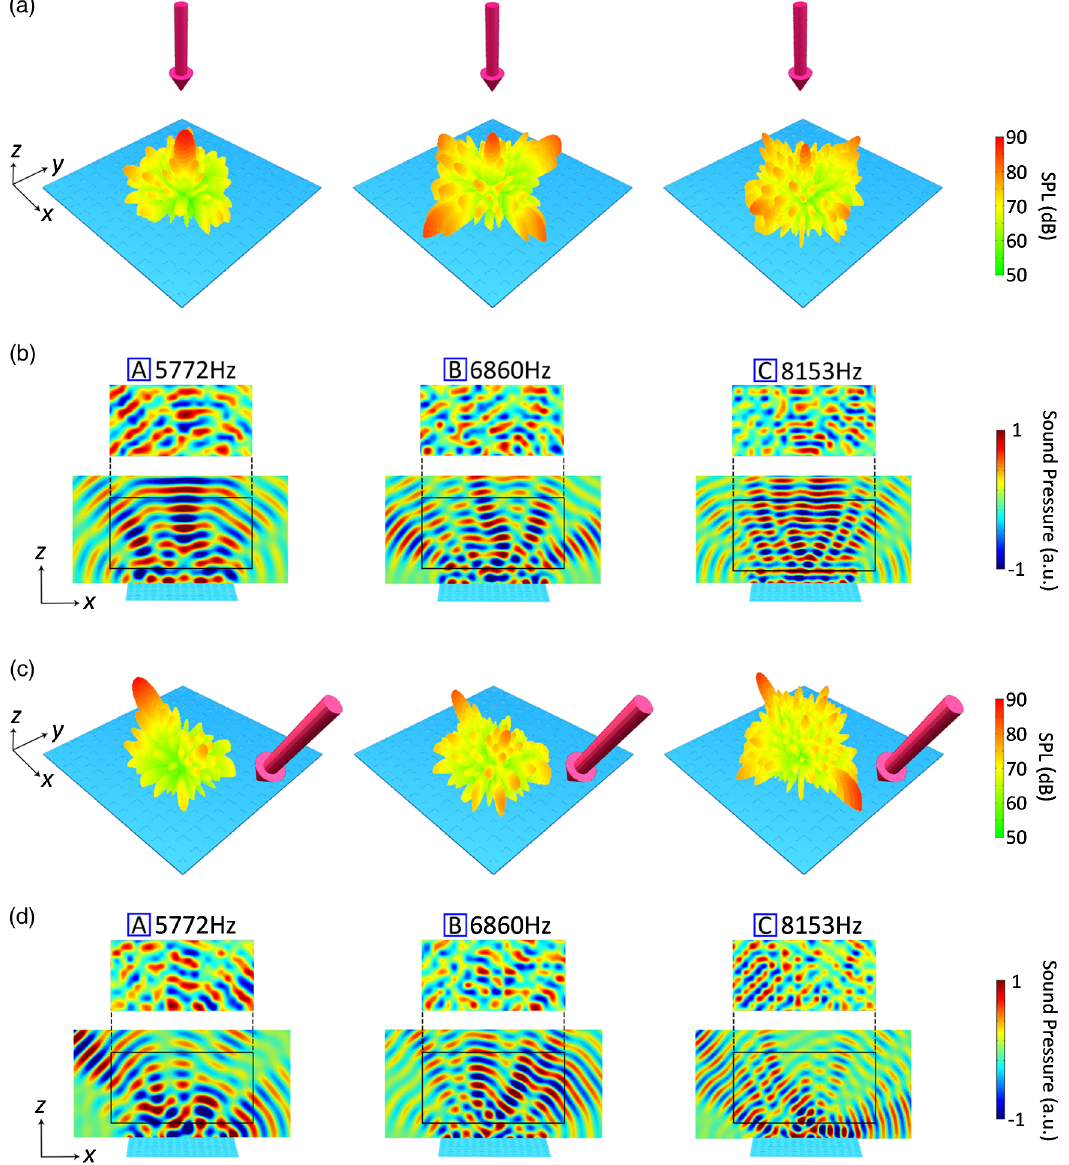
FIG. 6. Simulation and experiment results of the BMSD. (a) The simulated three-dimensional far-field scattering patterns of BMSD1 in the x - z plane at 5772 Hz, 6860 Hz, and 8153 Hz, respectively, with normal incidence. (b) The measured (upper) and simulated (lower) scattered acoustic pressure fields of BMSD1 in the x - z plane. The corresponding results for 45° incidence angles are shown in (c) and